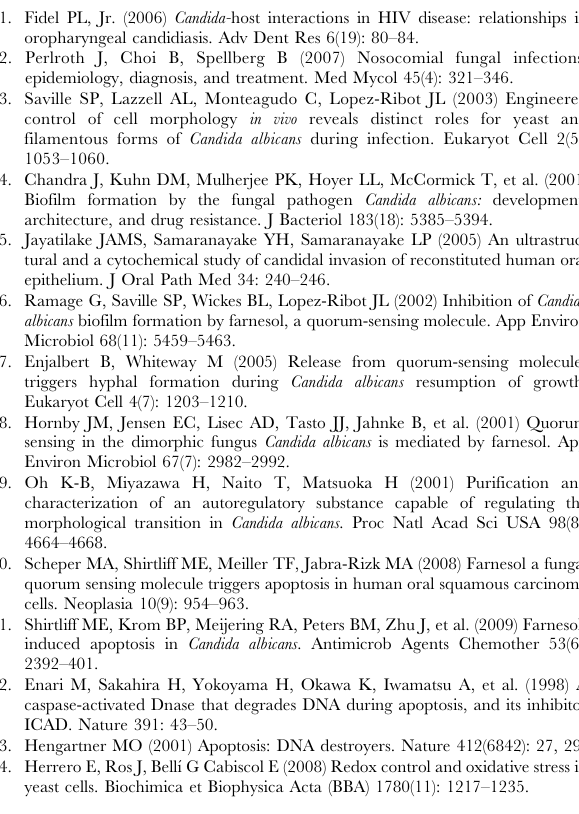
Figure S4 C. albicans viability as assessed by plate dilution method. Percent killing of C. albicans based on CFU counts is proportional to farnesol concentration and time of exposure with enhanced tolerance to farnesol upon GSH supplementation. Error bars indicate the standard errors of the means. (TIF) Figure S5 RT-PCR gene expression analysis of C. albicans strains following induction of CDR1 . Significant increase in the expression of CDR1 in the induced FL3 compared to wild-type with no expression detected in the strains lacking the CDR1 gene ( cdr1 and DL1). (TIF) Figure S6 RT-PCR gene expression analysis of C. albicans GPX2 and GLR1 following 3 and 18 h exposure to farnesol. Significant increase in the expression of both genes at 18 h whereas only GPX2 is increased at 3 h.